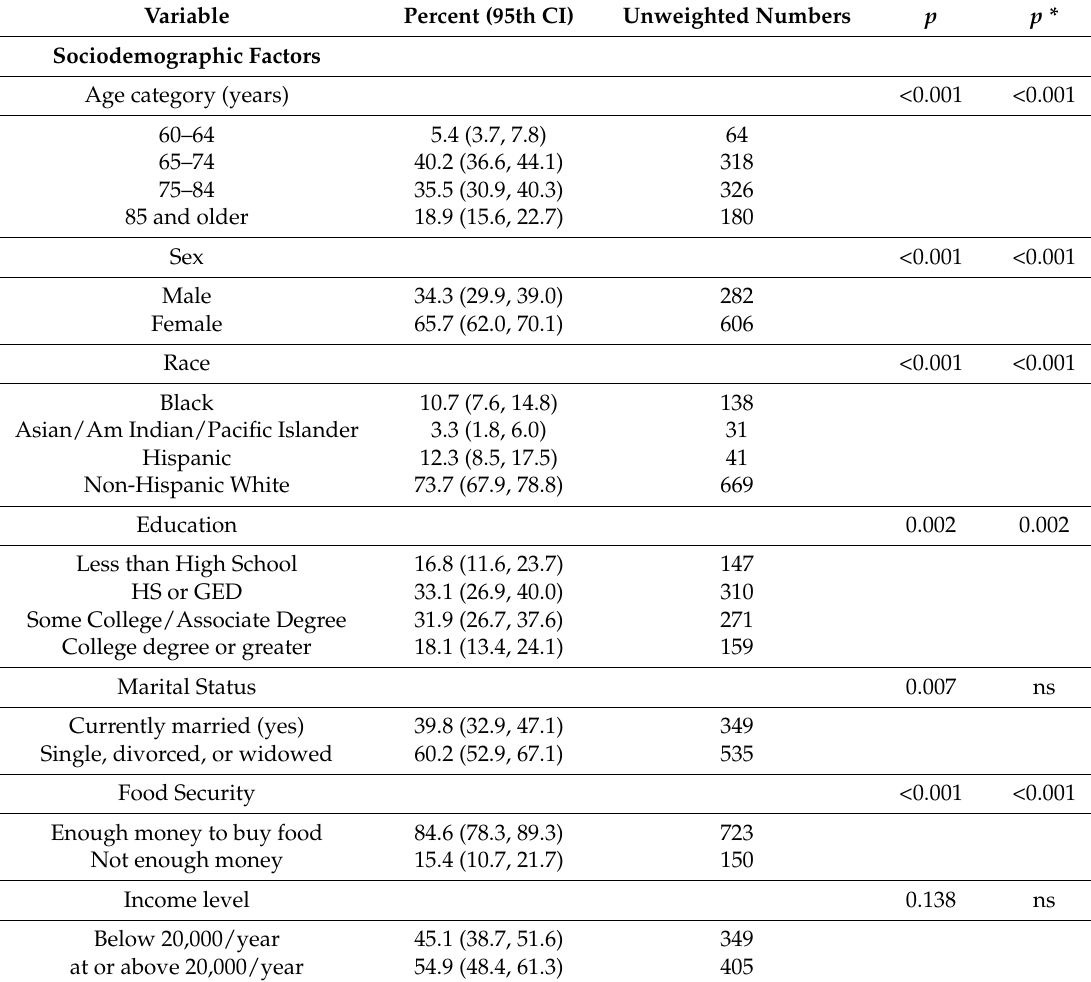
Table 1. Participants’ characteristics ( N =